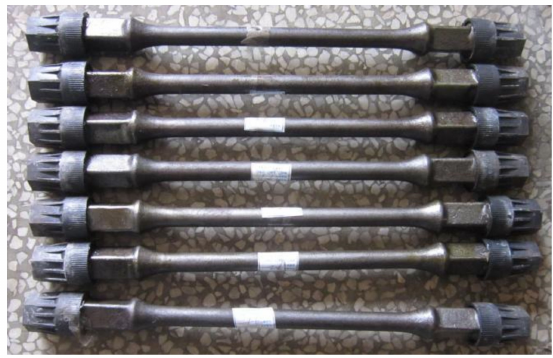
Figure 2. Actual images of sucker rod